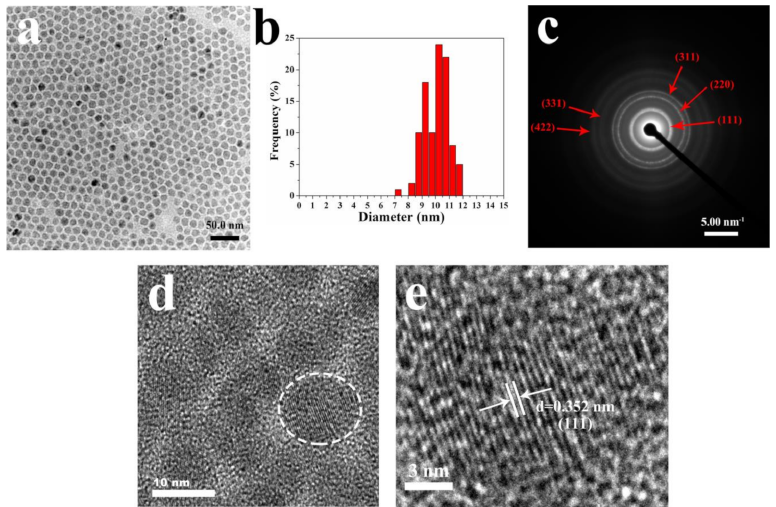
Figure 2. ( a ) TEM image of CdZnSeS-pATP QDs. ( b ) Size histogram with 100 particles in Figure 2a. ( c ) SAED pattern of particles in Figure 2a. The face symbols of diffraction rings of polycrystal are marked on the pattern. ( d ) HRTEM image of CdZnSeS-pATP QDs. The circled QD can be seen enlarged in ( e ) with its inter-planar spacing and face symbol